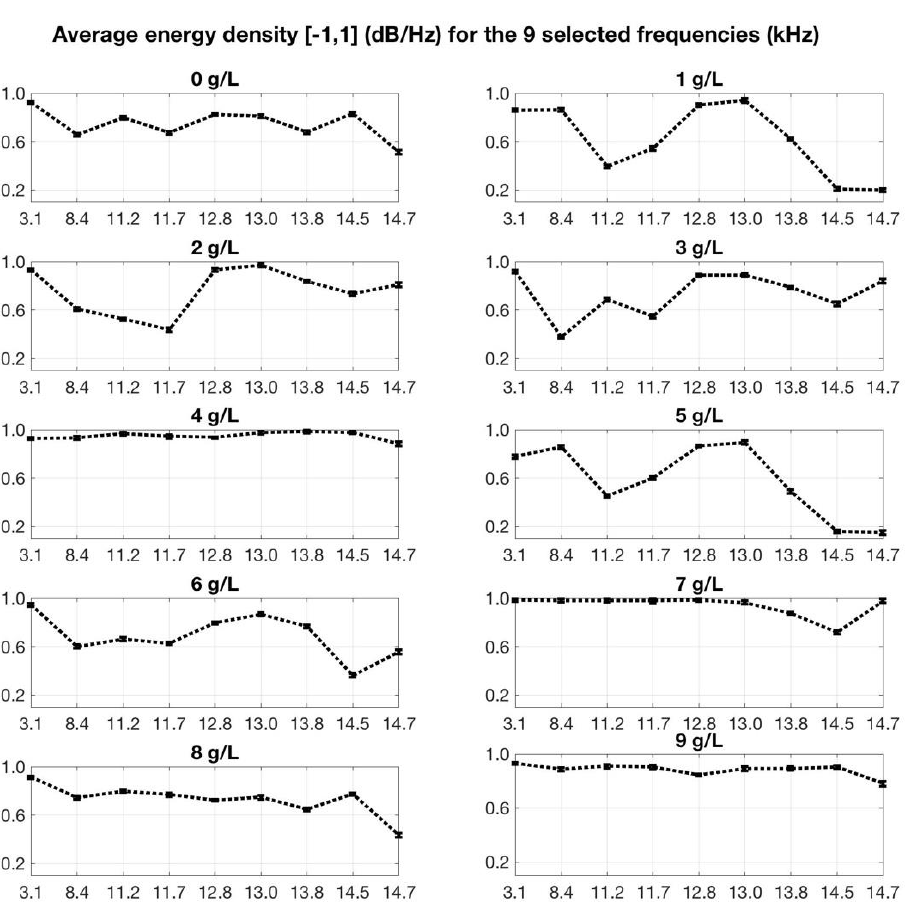
Figure 6. Spectral information patterns for fructose concentrations from 0 g/L to 9 g/L, with the average and normalized value of the sound pressure level (dB/Hz) as a function of the frequencies (kHz) used by the combined classifier.